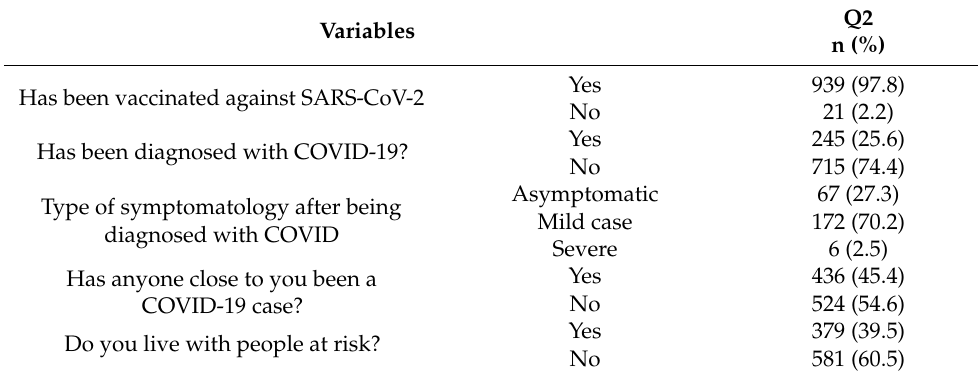
Table 5. Characteristics of the Q2 student population in relation to COVID infection 19.